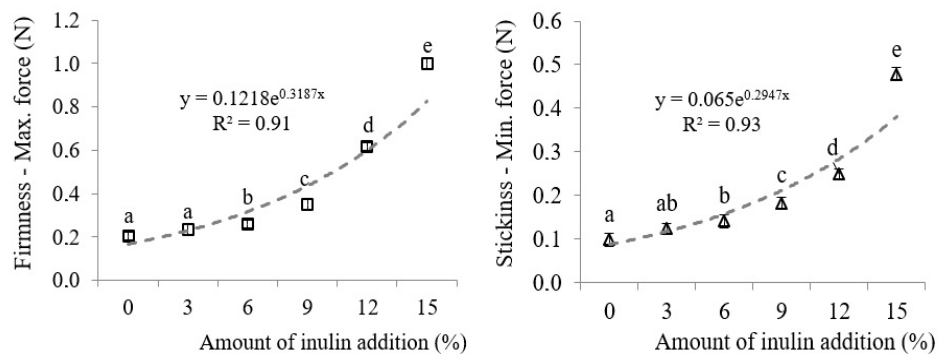
Figure 7. Firmness (maximum force) and stickiness (minimum force) of yogurts with 0%, 3%, 6%, 9%, 12% or 15% w/w inulin addition (a, b, c…—various letters for average values mean statistically significant differences, p < 0.05).